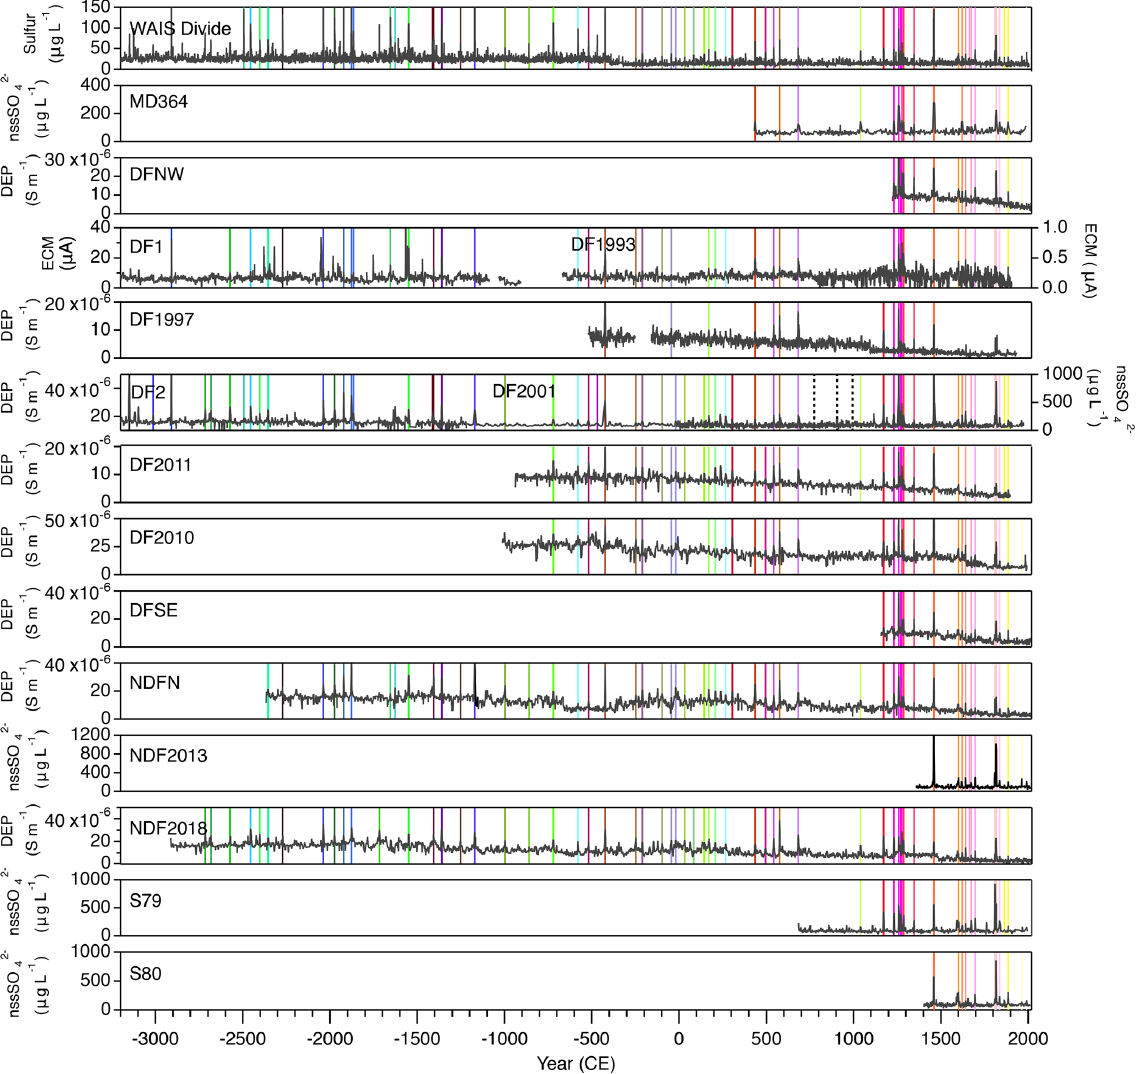
− for our ice cores and sulfur concentration of the WAIS Divide core (Cole-Dai, 2014a, b). Previously Figure 3. DEP, ECM or nssSO 2 4 published data are nssSO 2 − for 1900–1CE for the DF2001 core (right axis) (Motizuki et al., 2014), ECM for 1900CE–500BCE for the 4 DF1993 core (left axis), ECM for 900–3200BCE for the DF1 core (right axis) (Fujita et al., 2015), and DEP for 1200–3200BCE for the DF2 core (left axis) (Fujita et al., 2015). Other data are previously unpublished (see text). Vertical colored lines indicate volcanic tie points. Three dashed black lines for the DF2001 core indicate additional age tie points from published 10 Be– 14 C matching (Oyabu et al., 2022a). Age scales between the tie points were calculated with cubic spline interpolation. See Fig. B1 for the same data plotted against